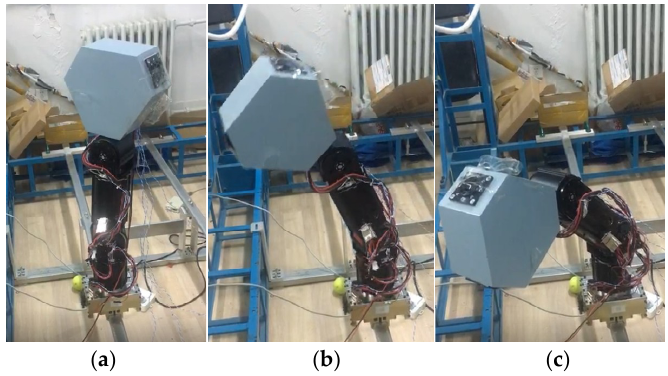
Figure 8. The motion of single arm under the no-load condition. ( a ) Motion start; ( b ) In the process of motion; ( c ) Motion complete.